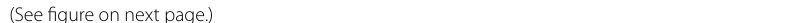
(Cyclophosphamide)(See figure on next Fig. 4 Polysaccharide effects were observed in-vitro using HCC cell lines A Cytotoxicity cell viability assay shows the effects of polysaccharide on LO-2, HepG2, and HCCLM3 cell lines. In comparison to normal cell lines, cancer cell lines showed a decrease in cell viability at 24, 48 h with three different concentrations 300, 400, and 500 µg/ml. B Polysaccharide inhibits colony formation abilities of cancer cells after treating for 48 h and showed a significant decrease in colony formation abilities of HepG2 and HCCLM3 cell lines in a dose-dependent manner. *p < 0.05, **p < 0.01, ***p 0.001. *PPO (Polysaccharide from Pleurotus ostreatus ), *CTX ≤